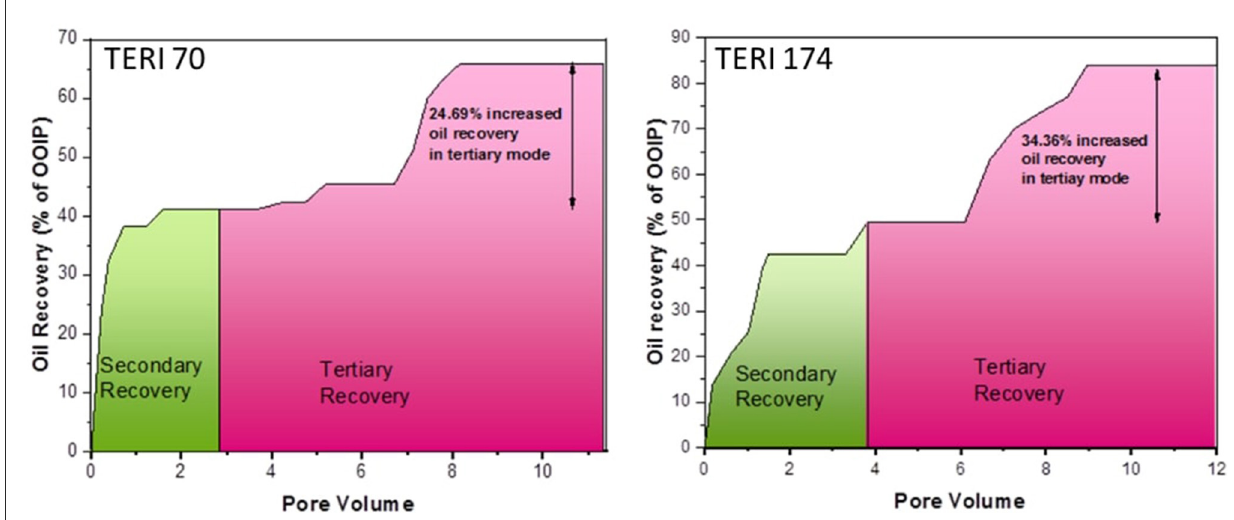
FIGURE10 Enhanced recovery of oil by microbial injection after water flooding.